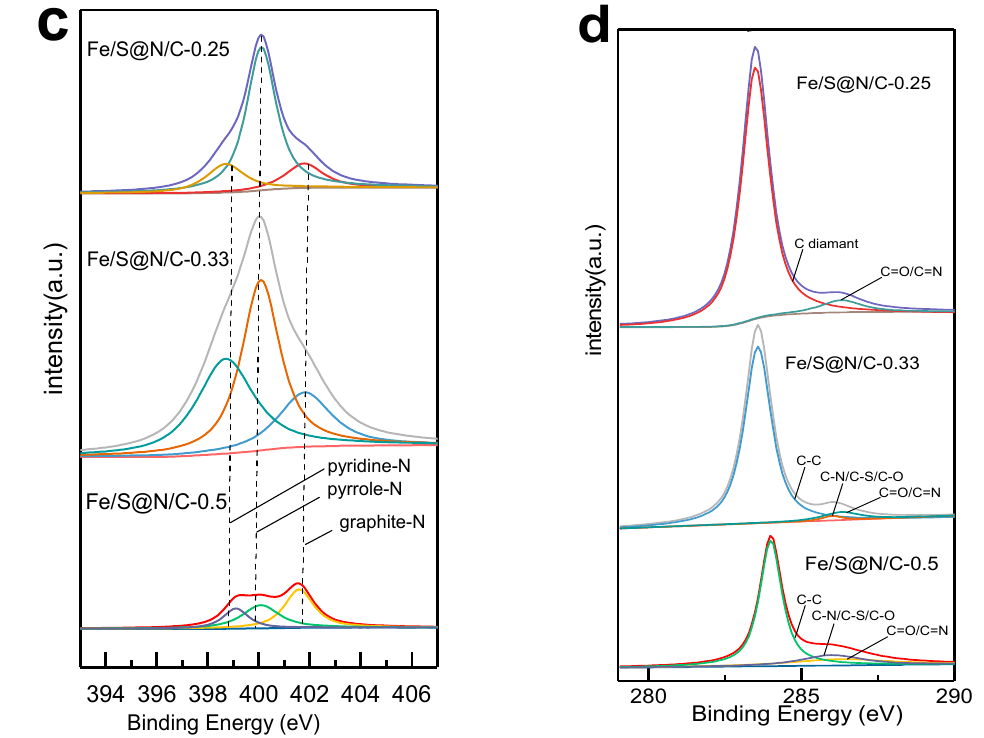
Figure 8. ( a ) High-resolution Fe 2p XPS spectrum of Fe/S@N/C-x. ( b ) High-resolution S2p N1s XPS spectrum of Fe/S@N/C-x. ( c ) High-resolution N1s XPS spectrum of Fe/S@N/C-x. ( d ) High-resolution C1s XPS spectrum of Fe/S@N/C-x. Table 4. Proportion of each element for Fe/S@N/C-x. Samples